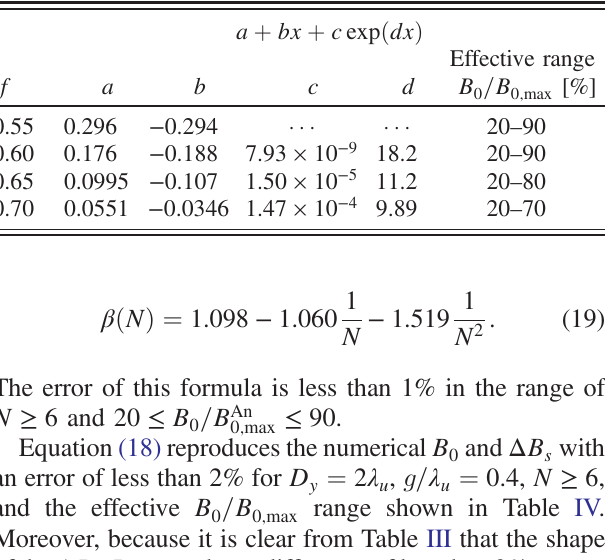
TABLE IV. Parameters for Eq.